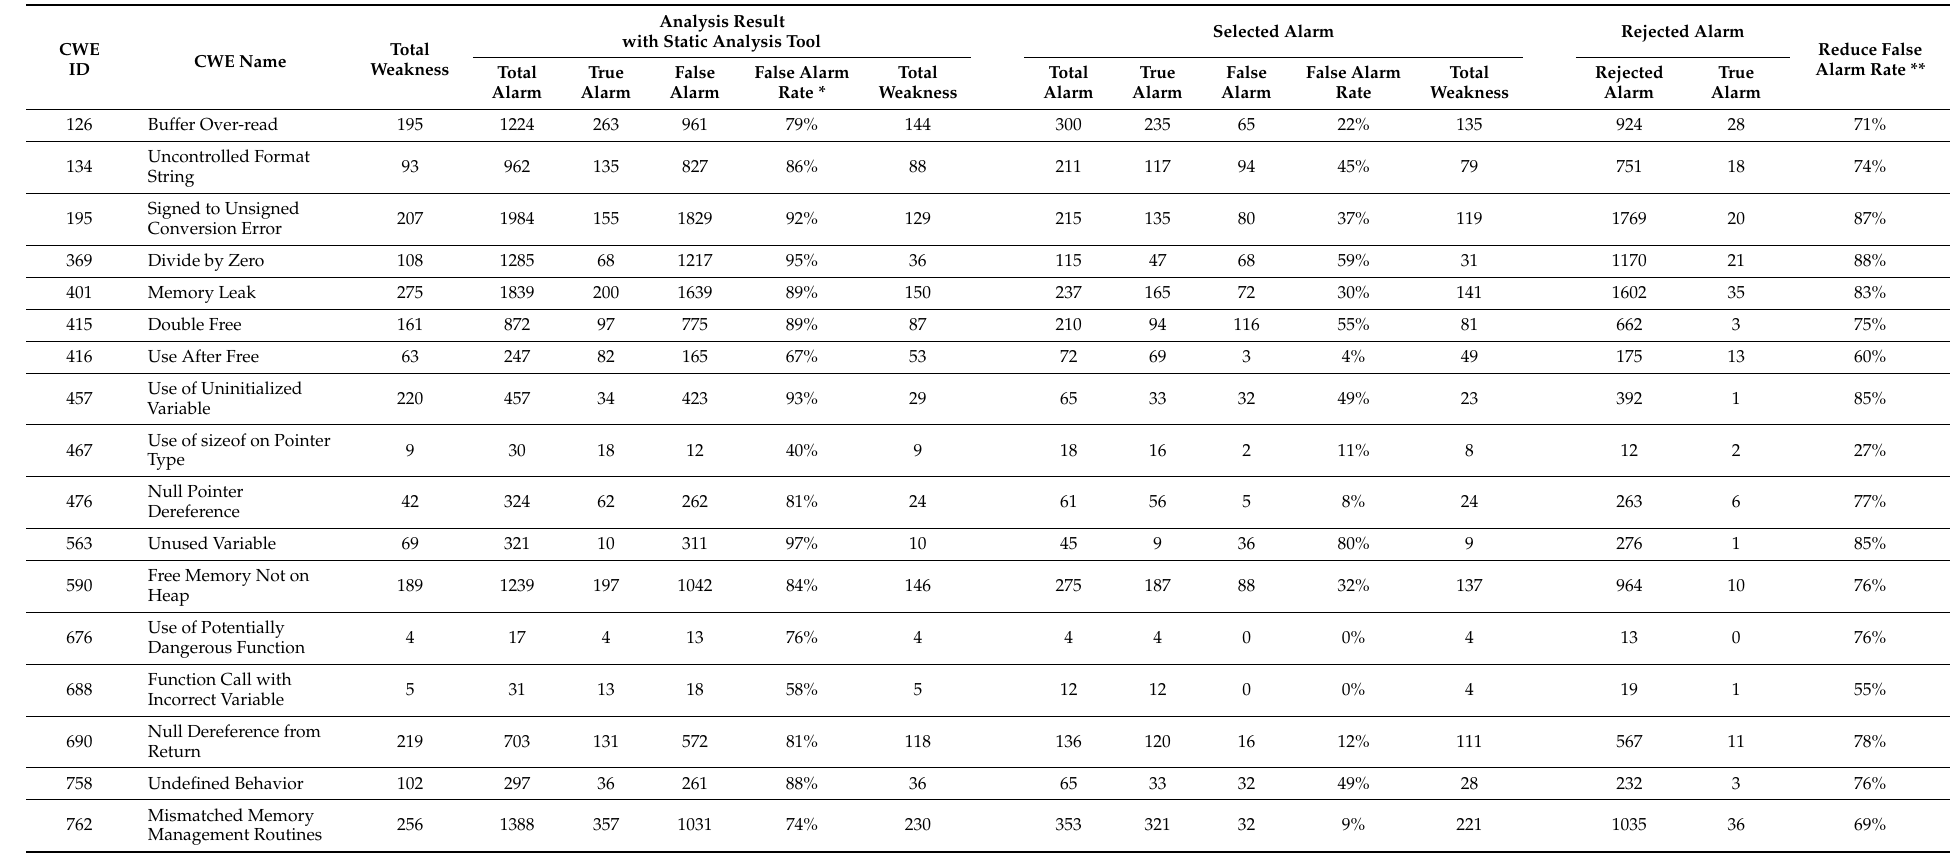
Table 6. Experimental results of proposed method for each